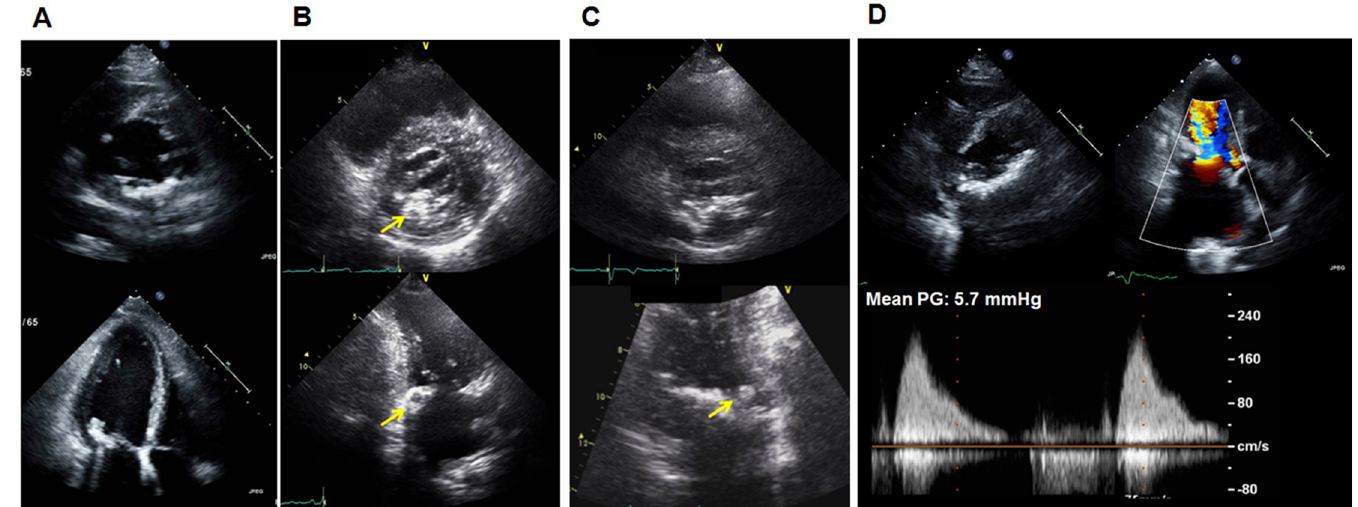
Fig 1. Representative cases. A) MAC in a patient without previous history of stroke: MAC is encircling the posterior mitral annulus without a mobile component, caseous necrosis, or functional stenosis. The MAC score of the patient is 0. B) MAC in a patient with previous history of stroke: Extent of MAC is similar to that in patient A; however, caseous necrosis of MAC (large, round, echodense mass with central areas of echoucencies) is noted at the posterior mitral annulus. The MAC score of the patient is 1. The arrow indicates caseous necrosis of MAC. C) MAC in a patient with previous of history of stroke: MAC is encircling the posterior annulus and has an attached mobile component. The MAC score of the patient is 1. The arrow indicates mobile components of MAC. D) MAC in a patient with previous of history of stroke: Flow acceleration is observed across the MV, and MAC is the encircling posterior annulus. Doppler image shows increased MDPG (5.7 mmHg, HR: 50 bpm). The MAC score of the patient is 1.